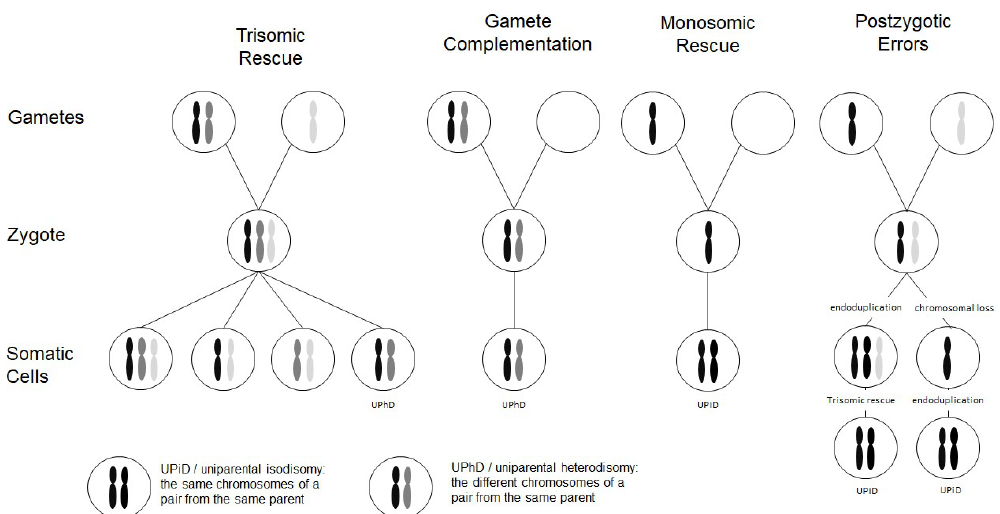
Figure 1. Scheme depicting the four major formation mechanisms of whole chromosome uniparental disomies (UPDs). As it can be delineated from these modes of formation, mosaicism of a UPD cell line as well as an aneuploidy cell line is possible in case of trisomic rescue and postzygotic errors (for further details see [2]). It should be noted that in case of monosomic rescue and postzygotic nondisjunction, uniparental idisomy of the whole chromosome can be observed, whereas in the other modes of formation, uniparental heterodisomy can be interrupted by stretches of uniparental disomy. Formation of segmental UPD as well as UPDs caused by structural chromosomal variants (like Robertsonian translocation) are not shown (for that issue see [3]).